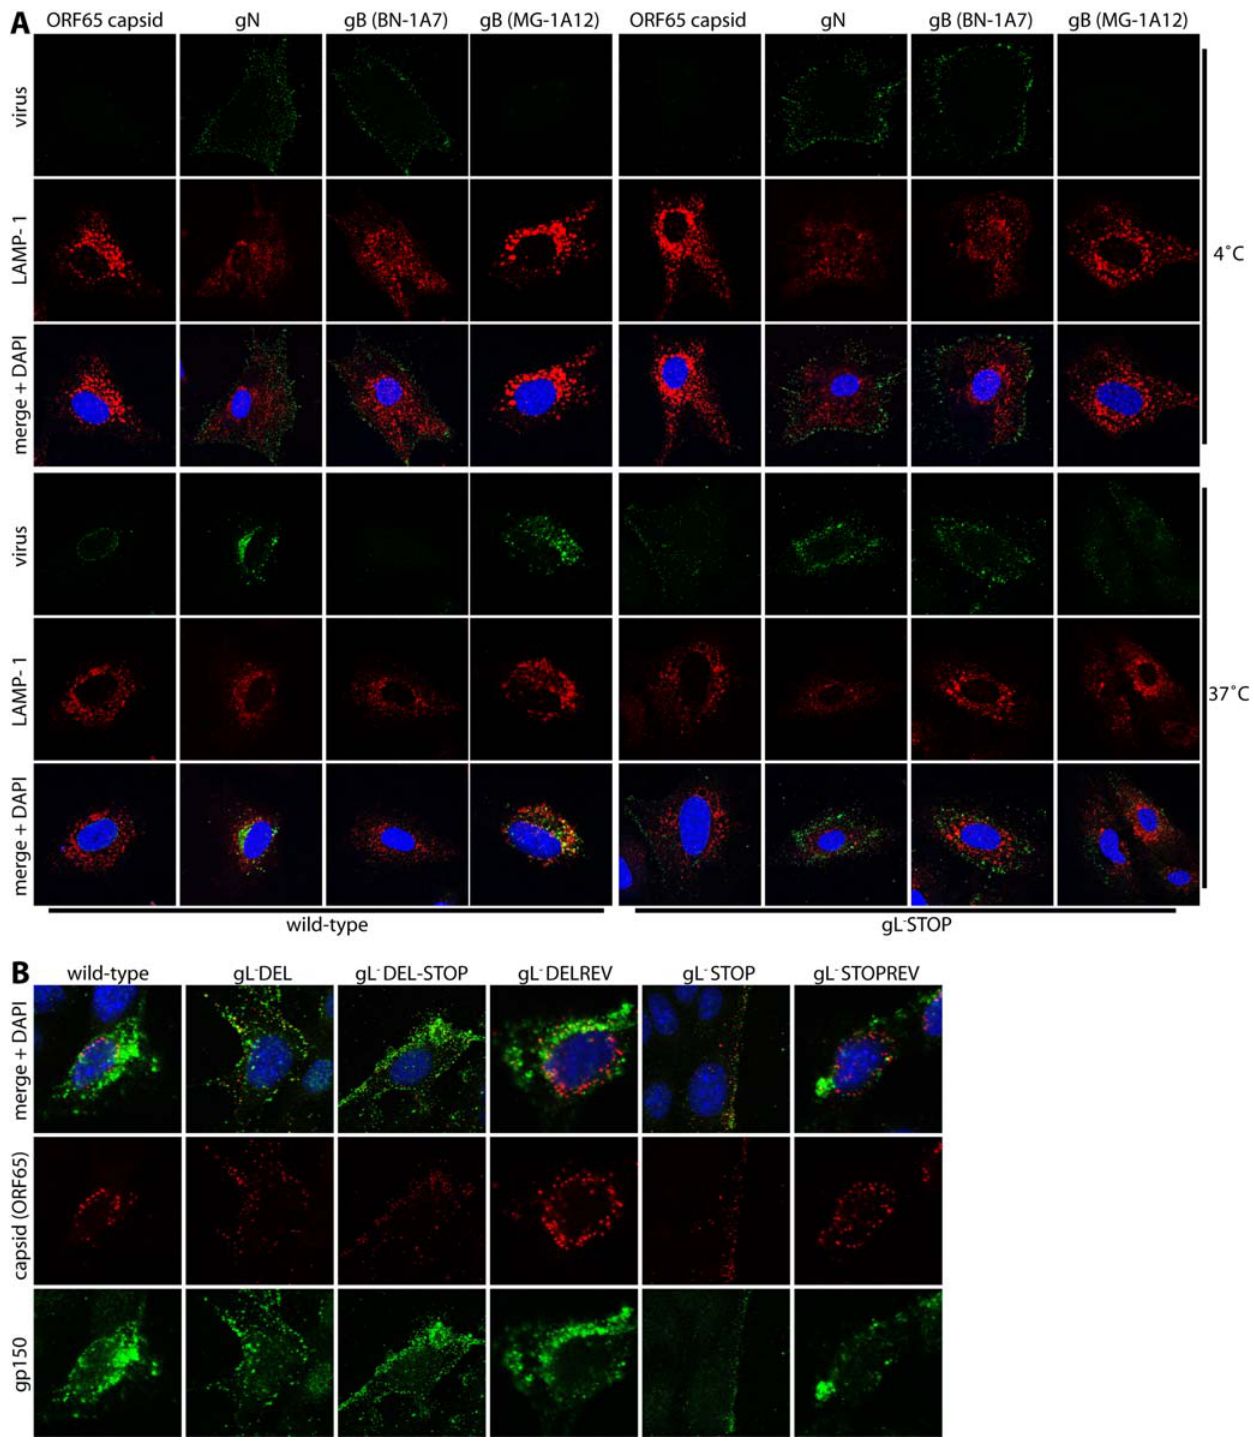
Figure 4. gL 2 virions show altered glycoprotein and capsid distributions and gB conformation changes. A. NMuMG cells were exposed to wild-type or gL 2 virions (2 h, 4 u C, 3 p.f.u./cell) then washed 6 3 in PBS and either fixed immediately (4 u C) or first incubated (2 h, 37 u C) to allow virion endocytosis (37 u C). The cells were then permeabilized and stained for LAMP-1 plus MuHV-4 capsid or glycoprotein antigens as shown. Nuclei were counterstained with DAPI. Colocalization appears as yellow in the merged images. Equivalent data were obtained in 3 further experiments. B. MCCD epithelial cells were incubated with a range of different gL 2 or gL + viruses (2 h, 4 u C, 3 p.f.u./cell), then washed 6 3 with PBS and incubated further (2 h, 37 u C) to allow virion endocytosis. The cells were then stained for gp150, an abundant virion glycoprotein, with mAb LS-B11 (IgG1) and for ORF65 capsid with mAb MG-12B8 (IgG2a). Nuclei were counterstained with DAPI.